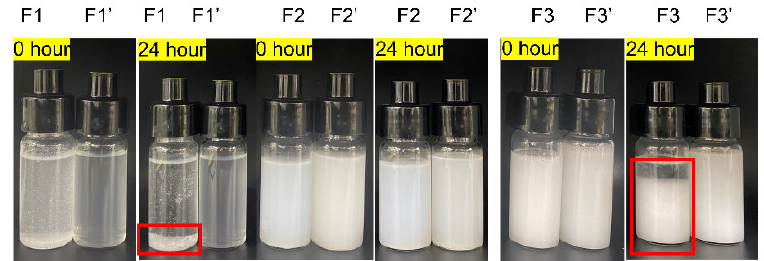
Figure 3. Photos of the different formulations at lowered pH (~5.5) for 24 h.